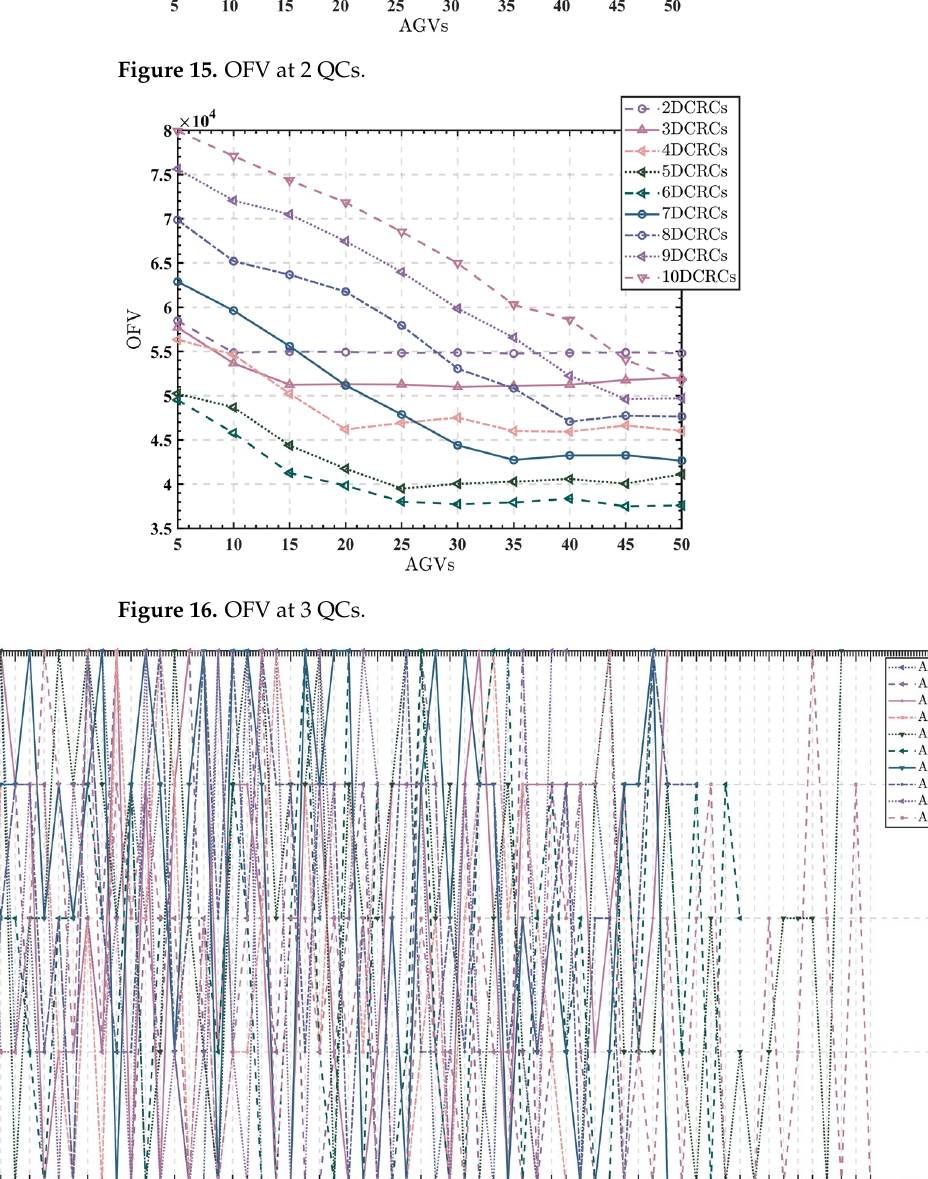
Table 3. Calculation example of 1 QC.